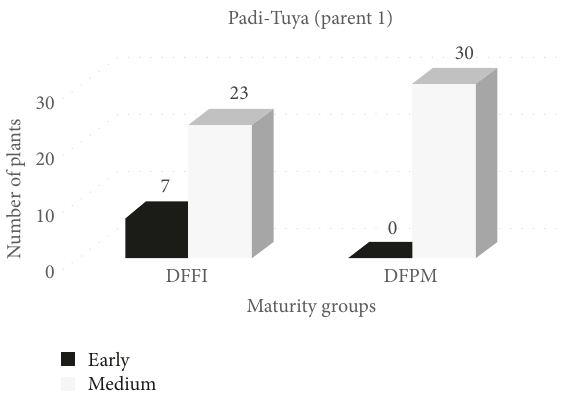
Figure 3: Frequency distribution analysis of DFFI and DNPM for